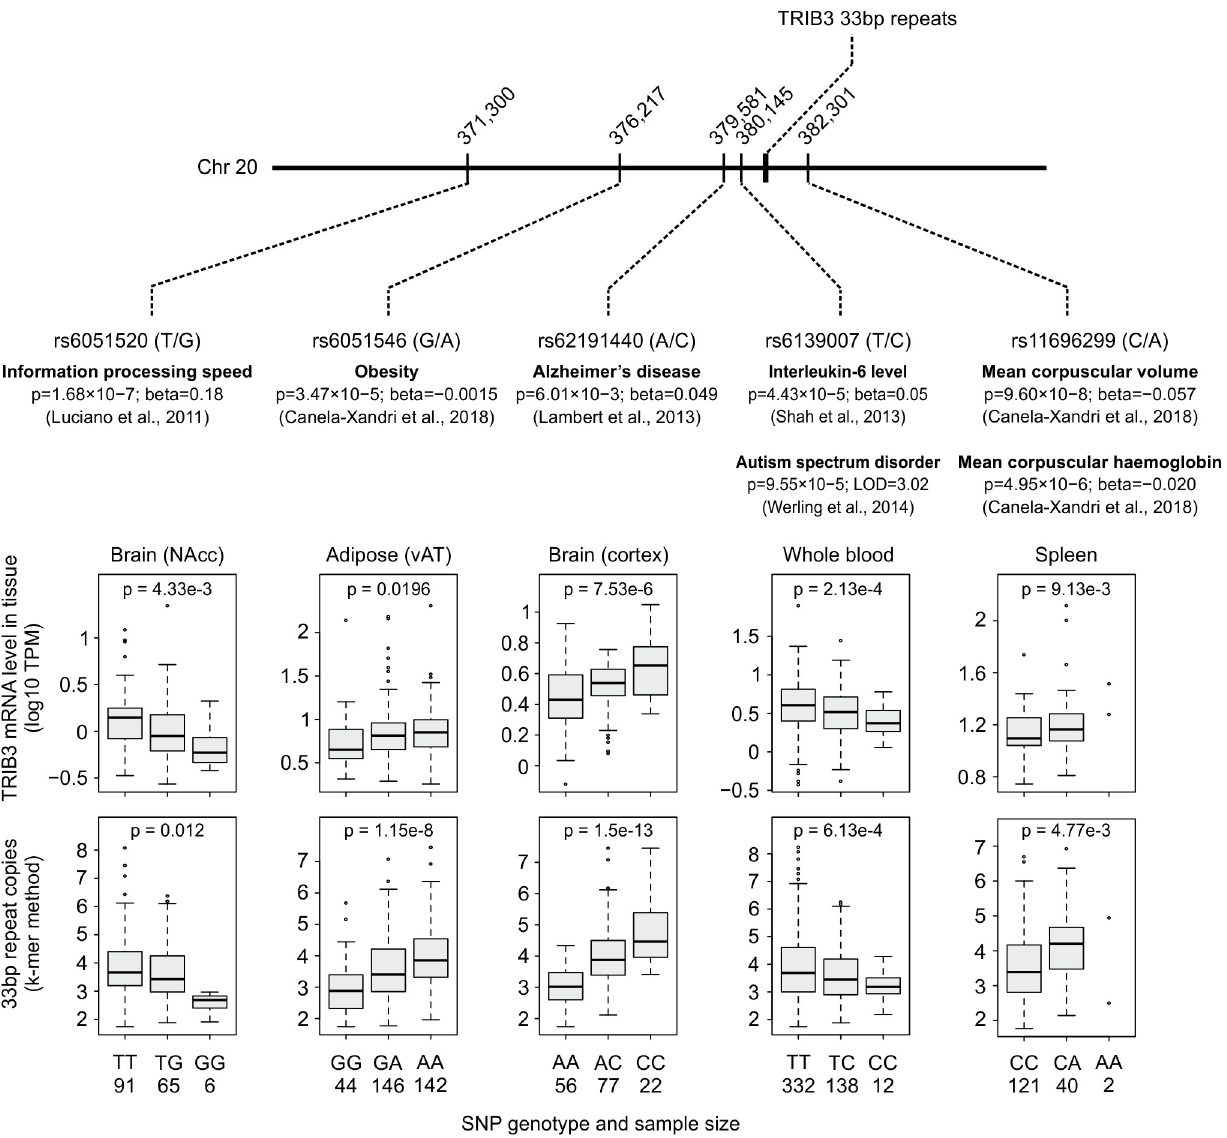
Fig 6. TRIB3 SNPs highlighted by genetic association studies are linked to 33-bp repeat copy number as well as TRIB3 mRNA expression in phenotype-relevant tissues. SNPs localizing near the TRIB3 33-bp repeat and associated (or suggestive) for human phenotypes based on GWAS, PheWAS or other genetic association studies are shown. Using RNA-Seq and whole genome sequencing data from GTEx v8, the association between the lead SNP genotype and TRIB3 RNA expression level or TRIB3 33-bp repeat copy number was calculated using linear regression for the SNP allele effect. The k-mer counting method was used to estimate the TRIB3 33-bp repeat copy number from genome sequencing reads.